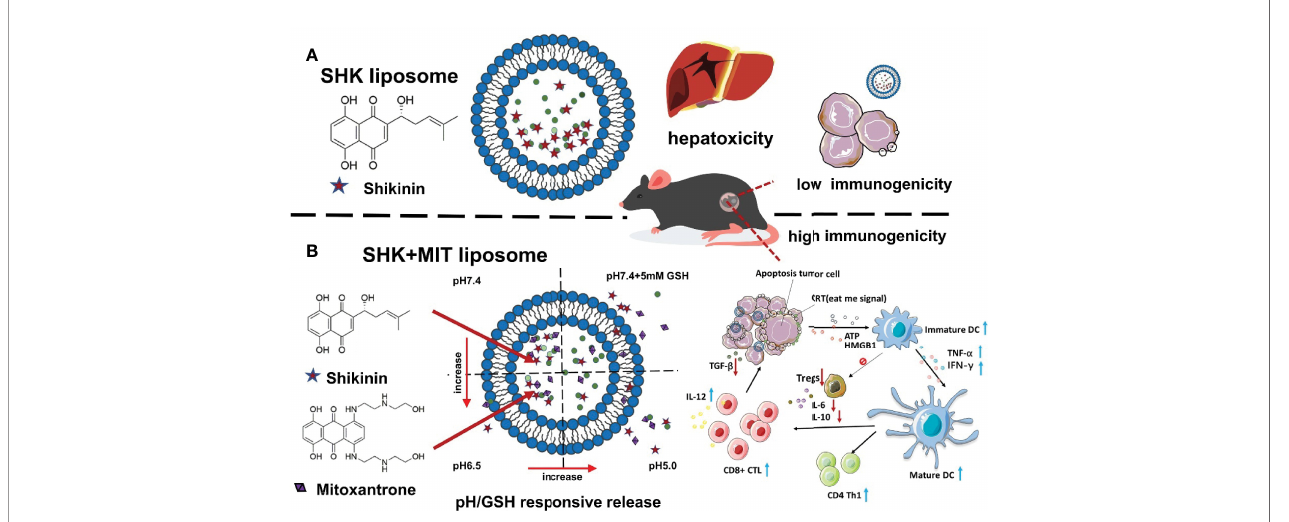
FIGURE 4 | SHK and MIT co-loaded liposomes with dual-responsive release for synergistic chemo-immunotherapy through ICD. (A) Result of limited immunogenicity, SHK liposomes may cause hepatotoxicity. (B) Inducing strong apoptosis in cancer cells and stimulating an ICD effect and adaptive immune response using SHK and MIT co- loaded liposomes might shrink tumor volume and produce strong apoptosis in cancer